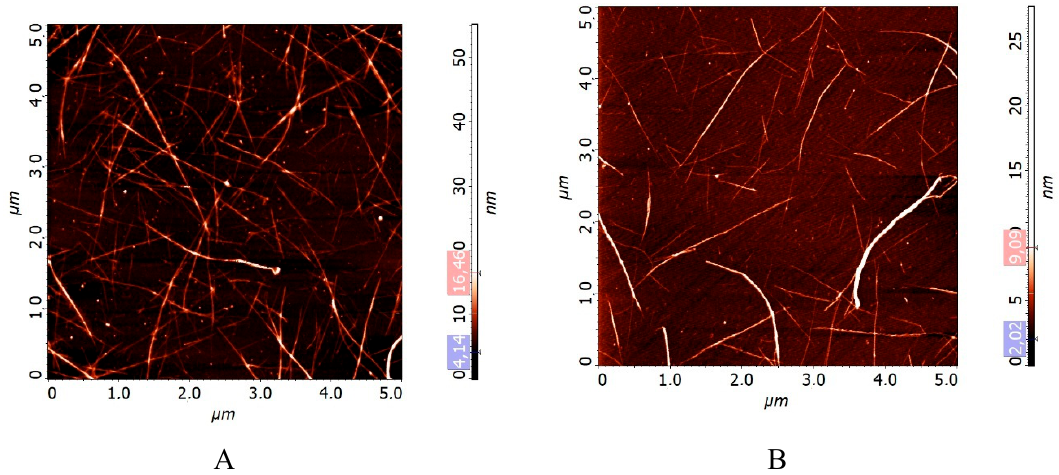
Figure 2. Carbon nanotubes atomic force microscopy (CNT AFM). Before ( A ) and after ( B ) CO 2 processing at a pressure of 75 bar and a temperature of 80 °C.